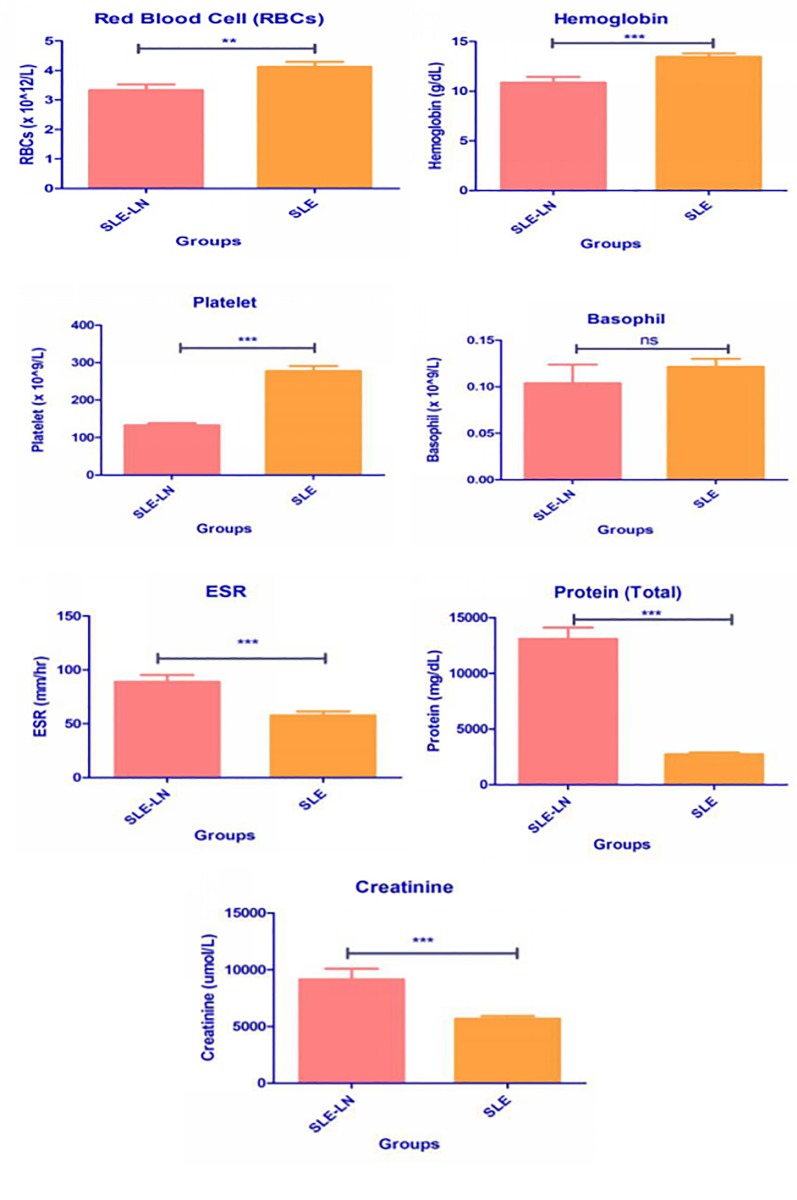
Levels of red blood cells (× 1012/L), hemoglobin (g/dL), platelet ((× 109/L), Basophil ((× 109/L), ESR (mm/hour), protein (mg/dL), and creatinine (umol/L).